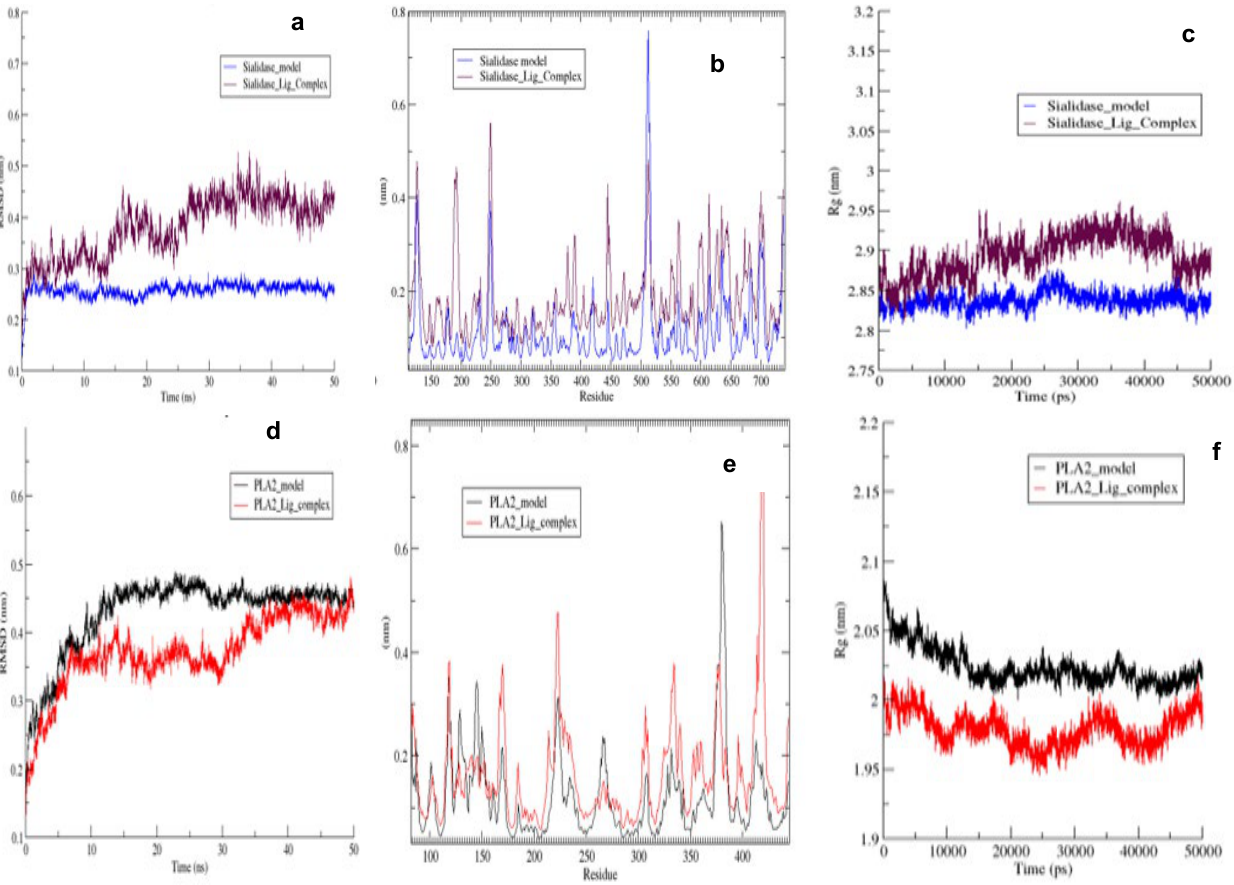
Figure 11. Molecular dynamics trajectory plots of unbound modelled trypanosomal sialidase and PLA 2 in complex with phloroglucinol. RMSD ( a ) and ( d ), RMSF ( b ) and ( e ), ROG ( c ) and ( f ).